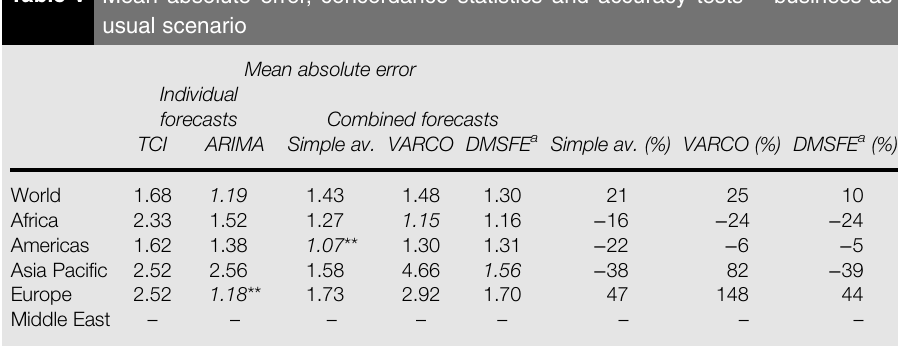
Table V Mean absolute error, concordance statistics and accuracy tests – business-as- usual